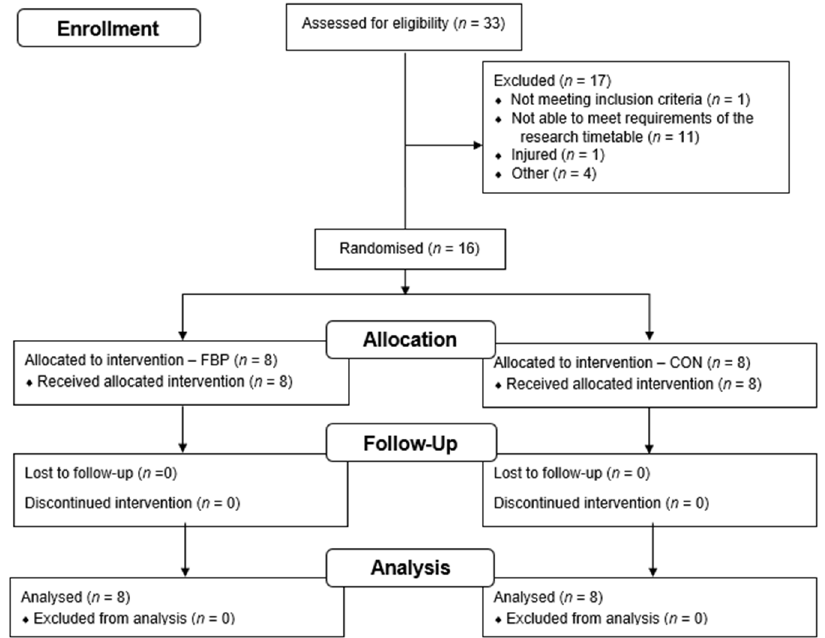
Figure 1. CONSORT flow diagram.